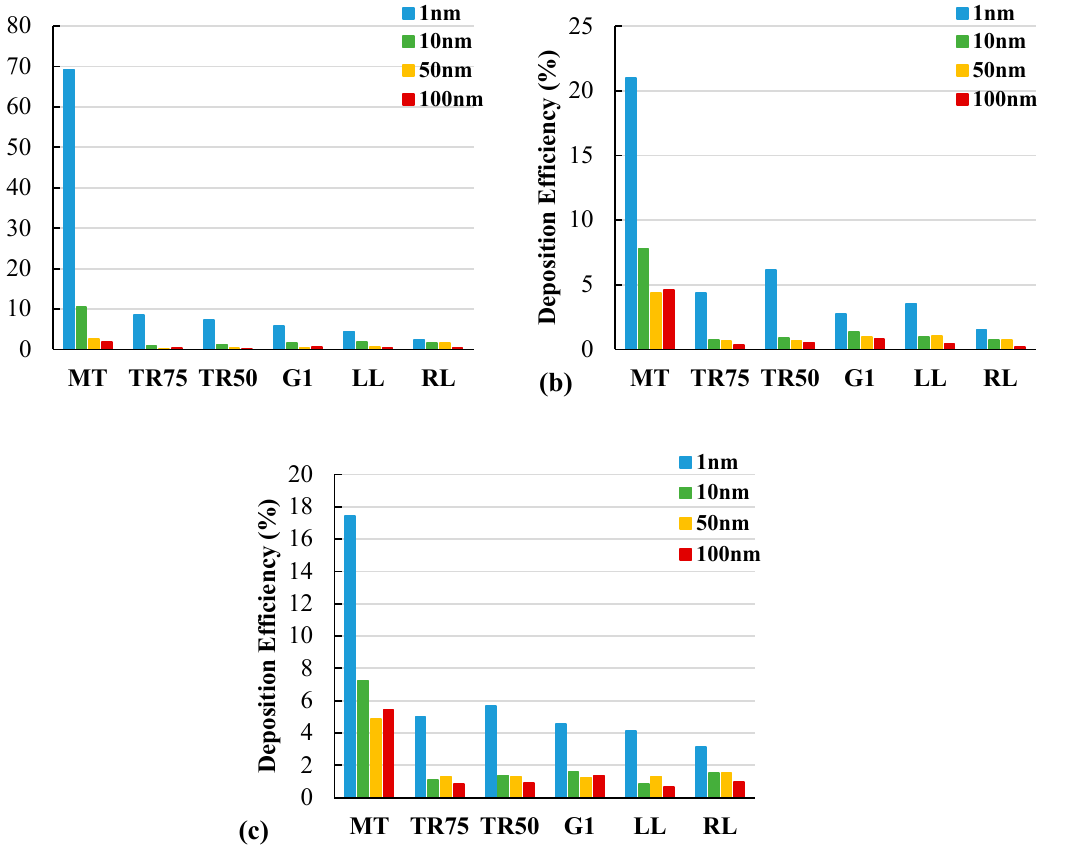
Figure 11. Particle deposition efficiency (DE) at various airway positions with three airflow rates: ( a ) 7.5 L/min; ( b ) 15 L/min; and ( c ) 25 L/min. MT, Mouth–throat; TR75, Trachea with stenosis 75%; TR50, Trachea with stenosis 50%; G1, Generation 1; LL, Left lung; and RL, Right lung.